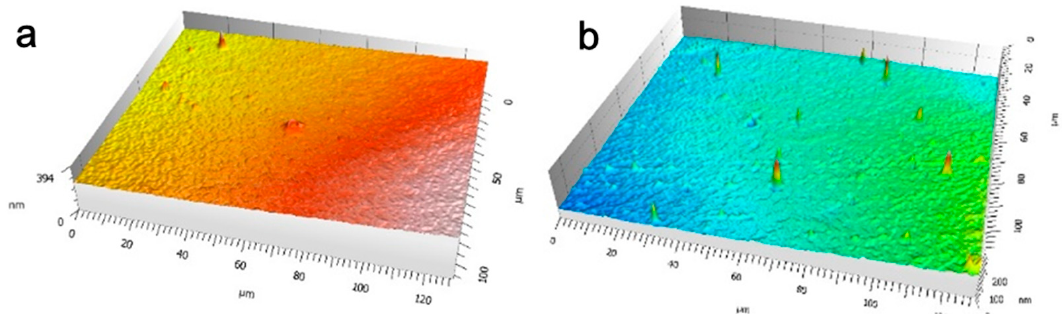
Figure 6. 3D surface topography of AF 1600 ( a ) and mZrO 2 @AF 1600 with 5.35 vol % mZrO 2 ( b ) monolayer film under 50 ‐ fold objective.